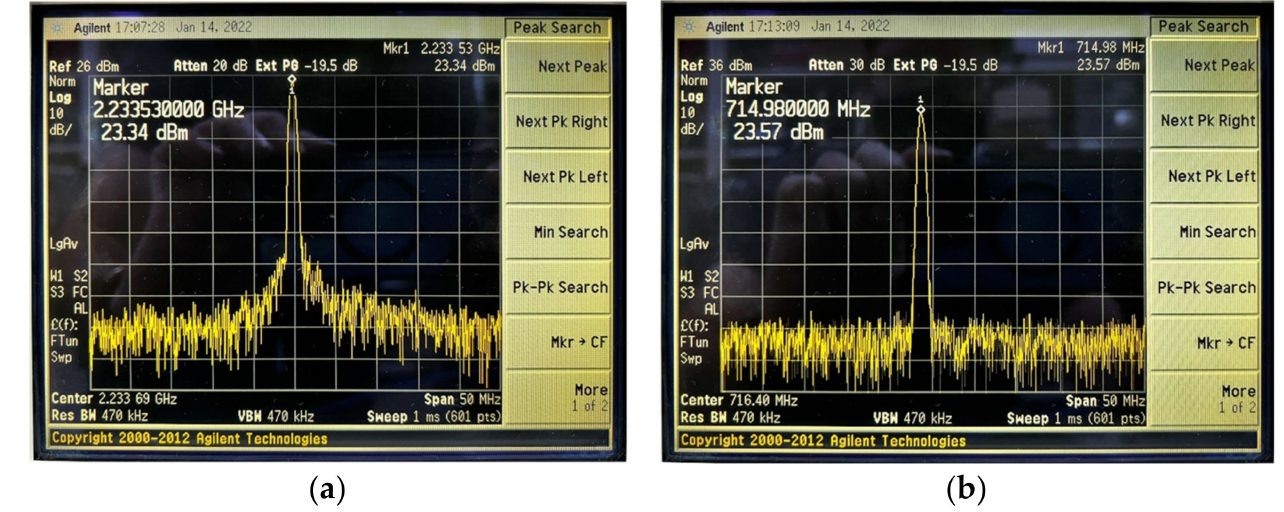
Figure 17. The maximum 23 dBm consistent power level for the ( a ) low and ( b ) high bands.